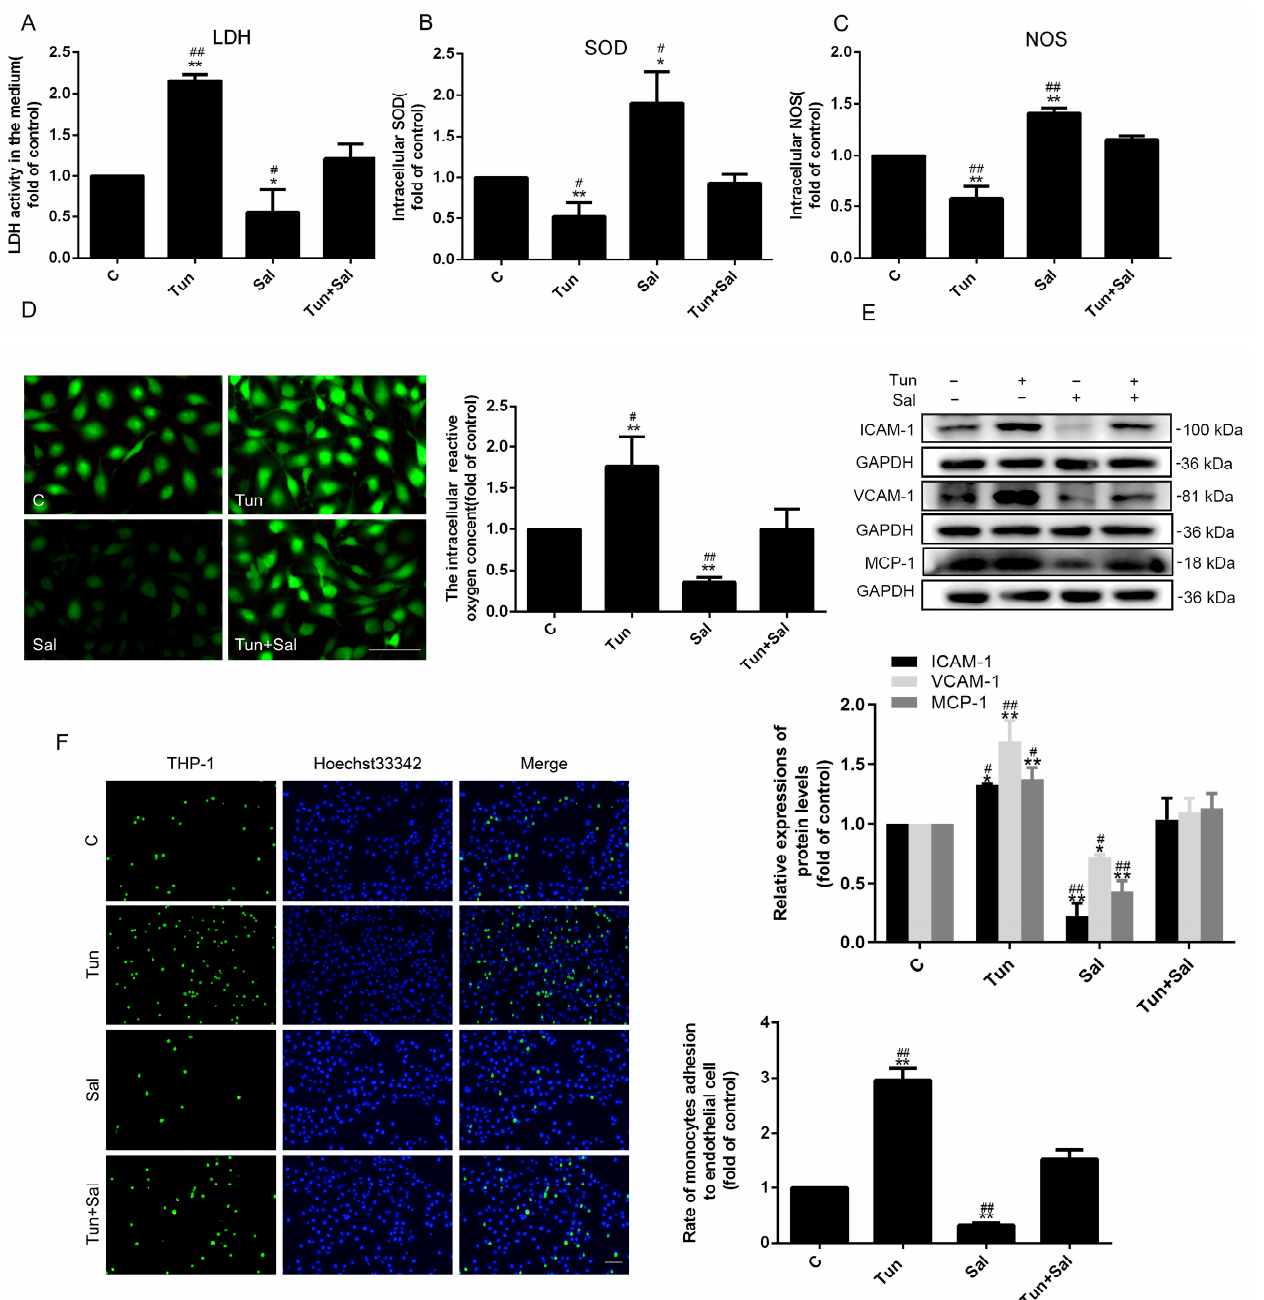
Figure 7. Activating ER stress can increase HUVEC cell damage and adhesion capacity, and inhibiting Wnt/ β -catenin pathway can attenuate HUVEC cell damage and adhesion capacity. ( A ) LDH, ( B ) SOD, and ( C ) NOS activity were detected by an enzyme activity kit. ( D ) The activity of ROS was detected by a DCFH-DA fluorescemce probe (15 µ mol/L), 10 × magnification. ( E ) The expressions of ICAM-1, VCAM-1, and MCP-1 were detected by Western blot. ( F ) The adhesion capacity of HUVEC was assessed by the number of attaching THP-1 (magnification 4 × ). n = 3, * p < 0.05 and ** p < 0.001 vs. the C group; # p < 0.05 and ## p < 0.001 vs. the Tun + Sal group. C, control group (treated by DMSO); Tun, cells treated with tunicamycin (10 µ mol/L) for 24 h; Sal, cells treated with salinomycin (5 µ mol/L) for 24 h; Tun + Sal, cells treated with tunicamycin (10 µ mol/L) for 2 h and then treated with salinomycin (5 µ mol/L) for 22 h. The scale of the images is 100 µ m.